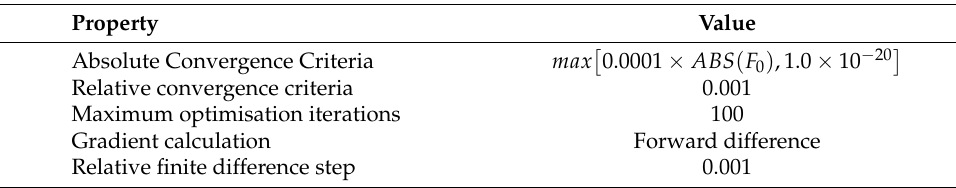
Table A2. DOT optimiser properties.